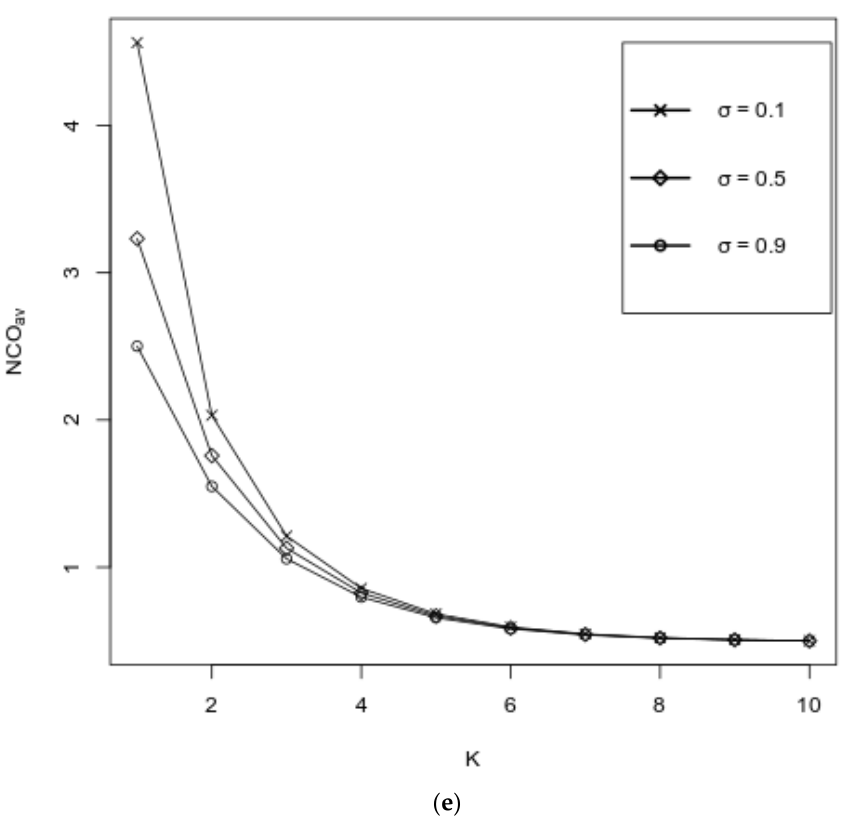
Figure 6. Loss probabilities of p -customers ( a ) and r -customers ( b ), the average number of busy ( c ) and failed servers ( d ) and the average number of r -customers in the orbit ( e ) versus the number of servers under various values of 𝜎 .